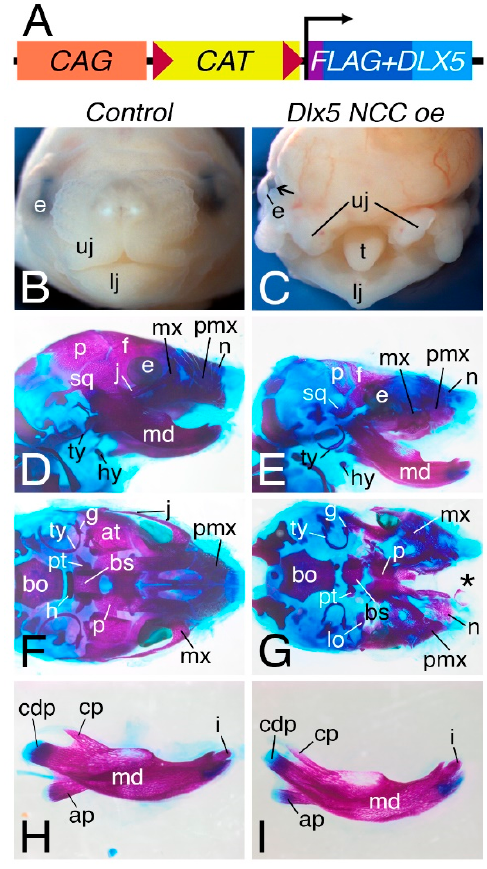
Figure 1. Neural crest cell (NCC)-specific Dlx5 overexpression results in midface clefting. ( A ) Diagram of the CAG-CAT-Dlx5 transgene. The CAG promoter drives expression of the Chloramphenicol acetyl transferase ( CAT ) gene that is flanked by loxP elements (triangles). Removal of Chloramphenicol Acetal transferase (CAT) via Cre-recombinase allows for persistent expression of Dlx5 . ( B , C ). Anterior and ventral whole mount views, respectively, of E16.5 heads from Control ( CAG-CAT-Dlx5 ) ( B ) and Wnt1-Cre; CAG-CAT-Dlx5 ( Dlx5 NCC oe ) ( C ) embryos. Compared to control embryos, the midface of Dlx5 NCC oe embryos contain a large cleft separating the upper jaw (uj) into left and right sides and exposing the tongue (t). The lower jaw (lj) also appears misshapen and a coloboma (arrow) is present. ( D–I ). E18.5 control ( B , D , F , H ) and Dlx5 NCC oe ( C , E , G , I ) embryos stained with Alizarin Red and Alcian Blue to visualize bone and cartilage, respectively. ( D , E ) Lateral views of skulls. In control embryos, the parietal (p) and frontal (f) are observed, which abut the squamosal (sq) bone ( D ). In the jaw region, the nasal (n), premaxilla (pmx), and maxilla (m) bones are observed, with the zygomatic process of the maxilla abutting the jugal (j) bone of the zygomatic arch. The tympanic ring (ty) bone is also observed. In Dlx5 NCC oe mice, the parietal, frontal bones are hypoplastic, as is the tympanic ring and squamosal bones ( E ). The premaxilla, maxilla, and jugal bones are dysmorphic, though the mandible appears relatively normal. ( F , G ) Ventral view of skulls with the mandible removed. In contrast to control embryos ( F ), most skull base bones in Dlx5 NCC oe embryos are hypoplastic, including the basisphenoid (bs), pterygoids (pt), and alisphenoids (al). The palatine (p) bones fuse along the midline but are also hypoplastic, as are the tympanic rings ( G ). The dysmorphology of the maxilla along the midline is also apparent, along with the large midline cleft that now exists (*). ( H,I ) Lateral (intra-oral) view of the left mandible (md). The coronoid (cp), condylar (cdp), and angular (ap) processes of the mandible are present in both control ( H ) and Dlx5 NCC oe ( I ) embryos, as are the incisors (i). bo, basisoccipital bone; e, eye; hy, hyoid